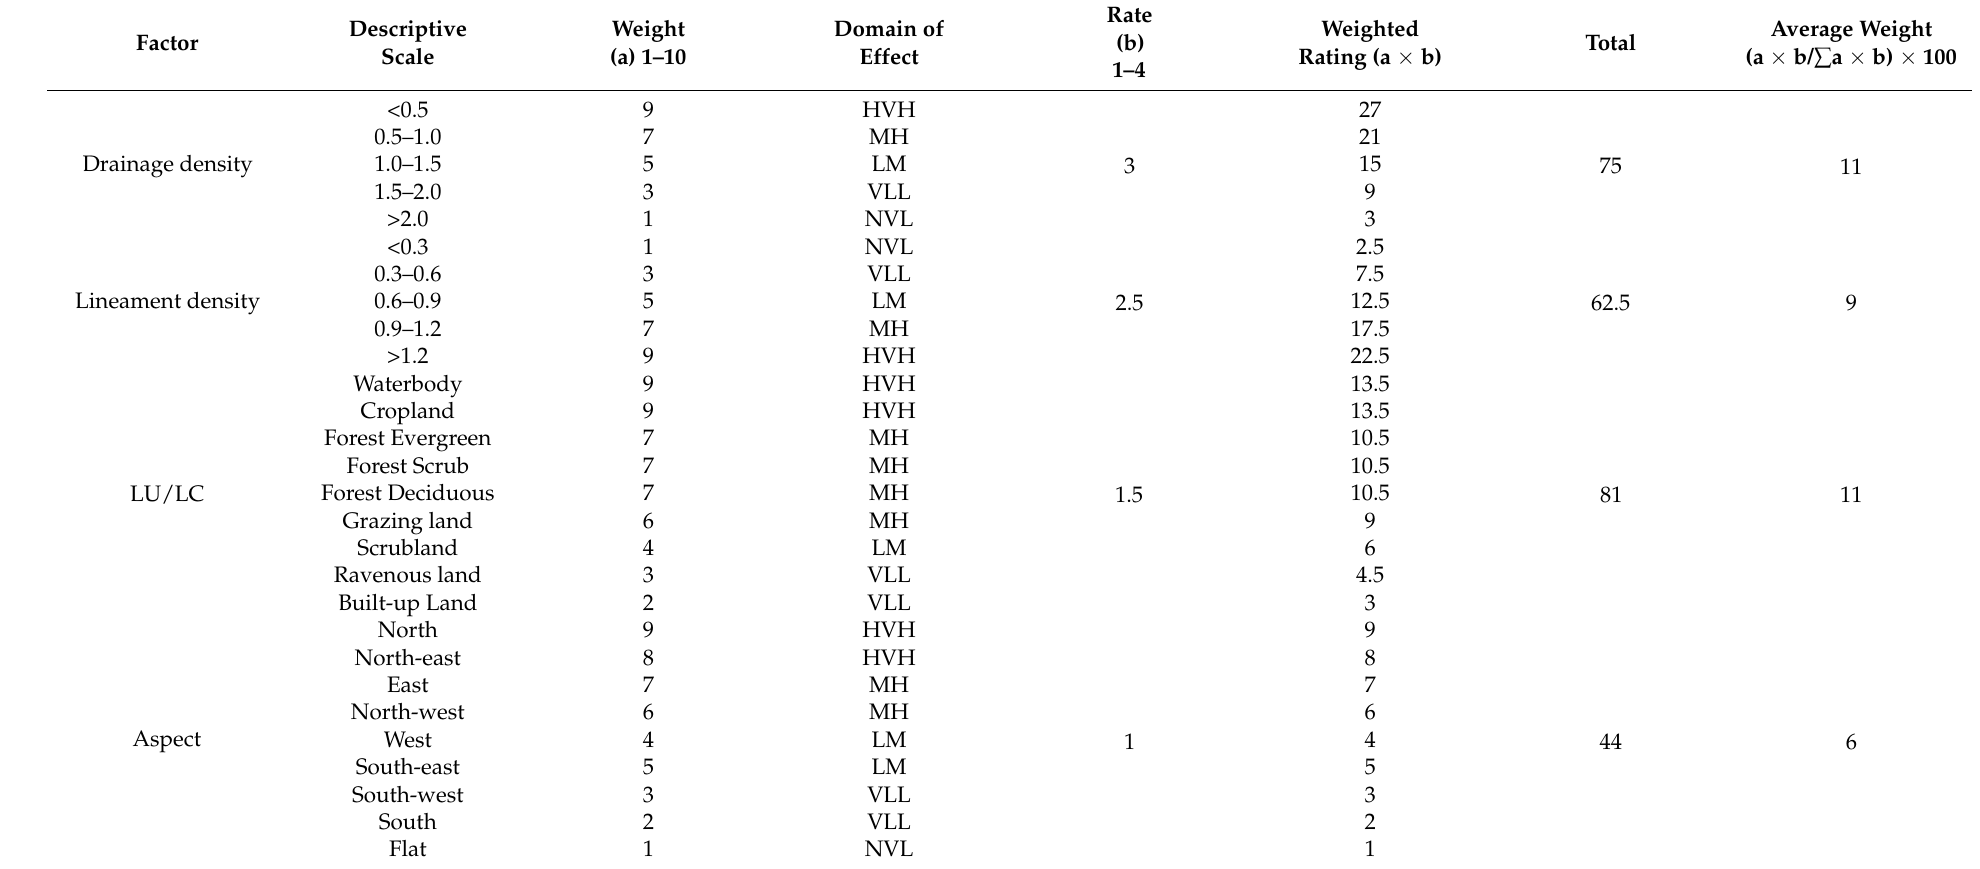
Table 2. Weight factors’ categorisation of influencing zones of potential